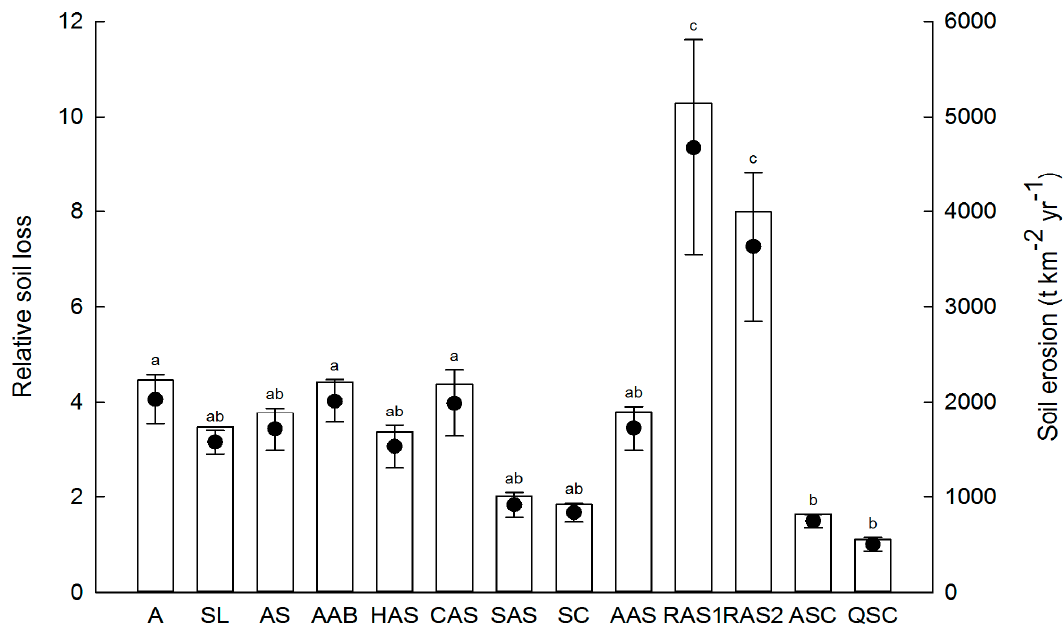
Figure 2. Soil erosion and relative soil loss in different plant communities under the extreme rainfall events during 2013. Vertical columns and black circles represent soil erosion and relative soil loss, respectively. Different lowercase letters indicate significance at p < 0.05 for relative soil loss between different plant communities. A: Artemisia scoparia (3–5 years); SL: S. bungeana + L. davurica (10–20 years);